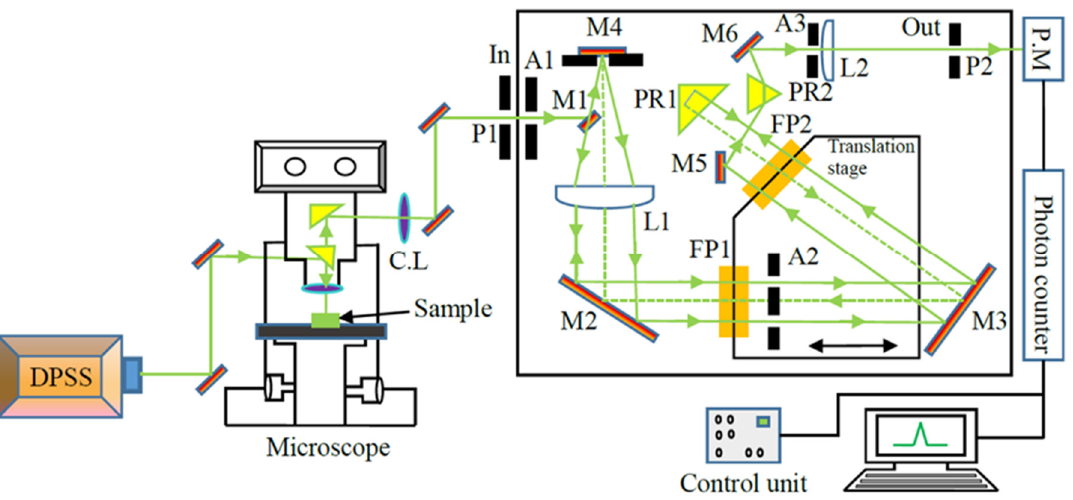
Figure 1. A schematic illustration of a Sandercock 3 + 3 pass tandem interferometer equipped with a photomultiplier and optical microscope [57,58].